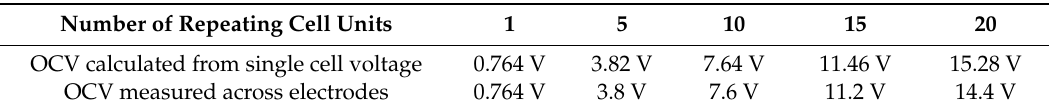
Table 3. Calculated and measured open circuit voltage (OCV) for 1 M acid and base at 25 ◦ C, depending on the number of repeating cell